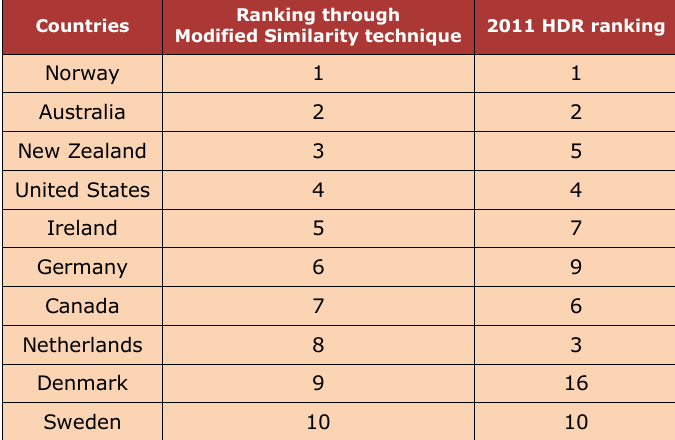
Table 8. First ten counties ranked through Modified